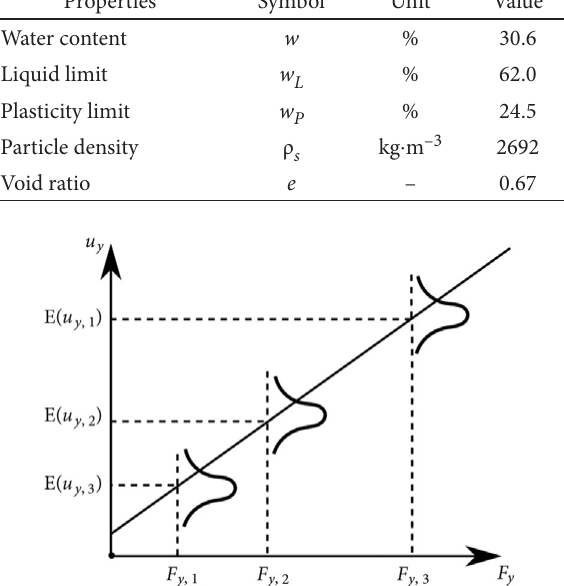
Fig. 2. Schematics of the stochastic dependence anchor head displacement versus proof